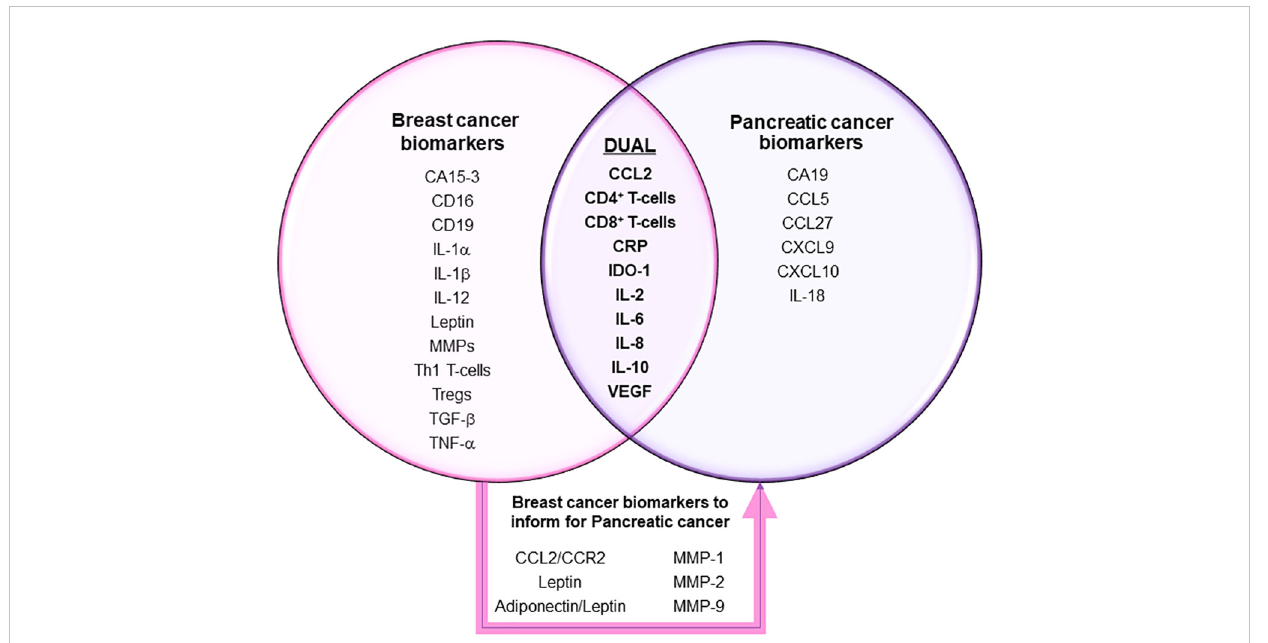
FIGURE 2 Clinically relevant in fl ammatory biomarkers in breast and pancreatic cancers. Markers in each sphere of the Venn diagram have been validated in many clinical trials to show clinical utility for diagnosis, prognosis and/or disease outcome indications for treatment or survival in breast and/or pancreatic cancers. Additional breast cancer-speci fi c markers highlighted within the box represent ones that may also show usefulness for pancreatic